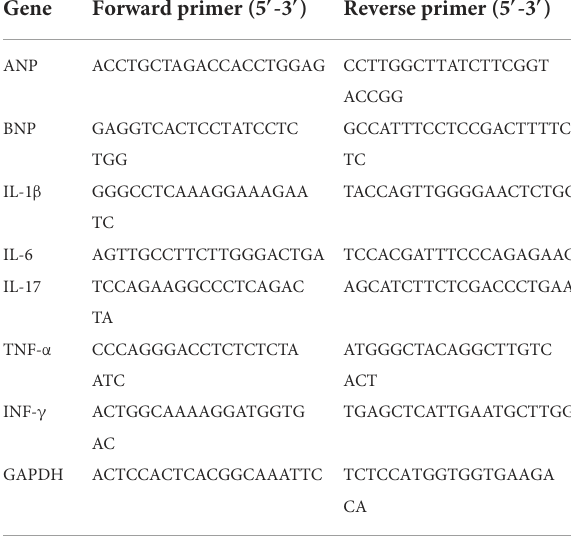
TABLE 1 All the primer sequences in this